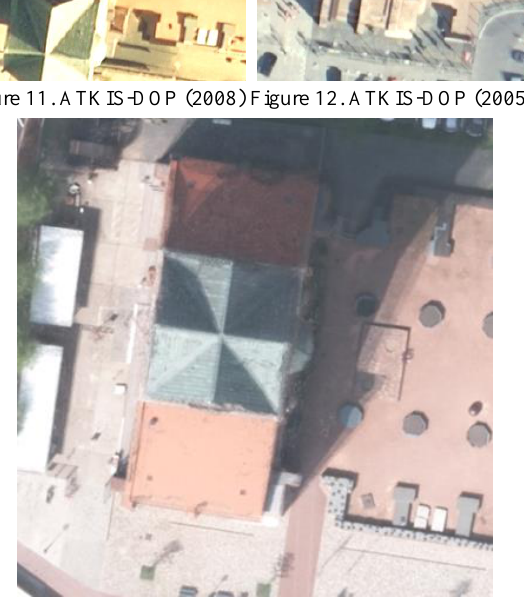
Figure 14. Forest in TrueDOP